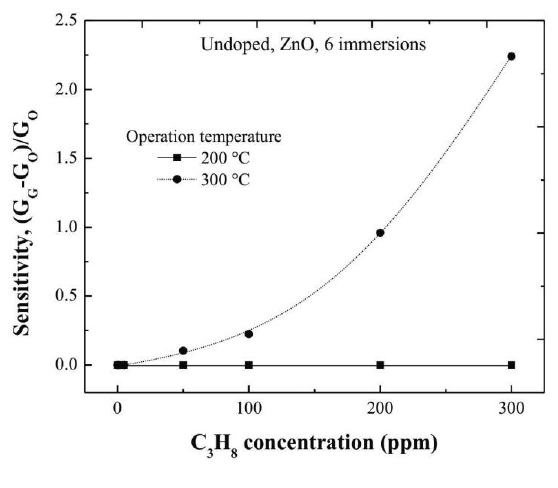
Figure 8. Sensitivity as a function of C measured 200 and 300